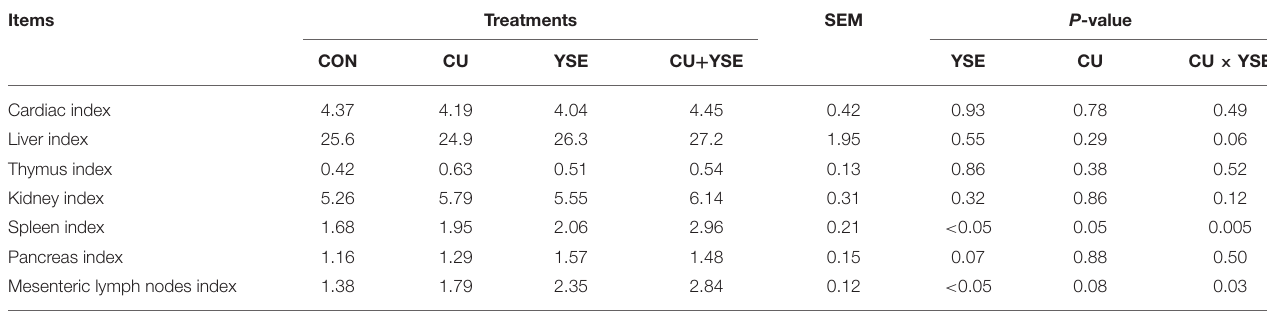
TABLE 3 | Effects of dietary YSE and oral CU on organ indexes in weaned piglets (g/kg). Items